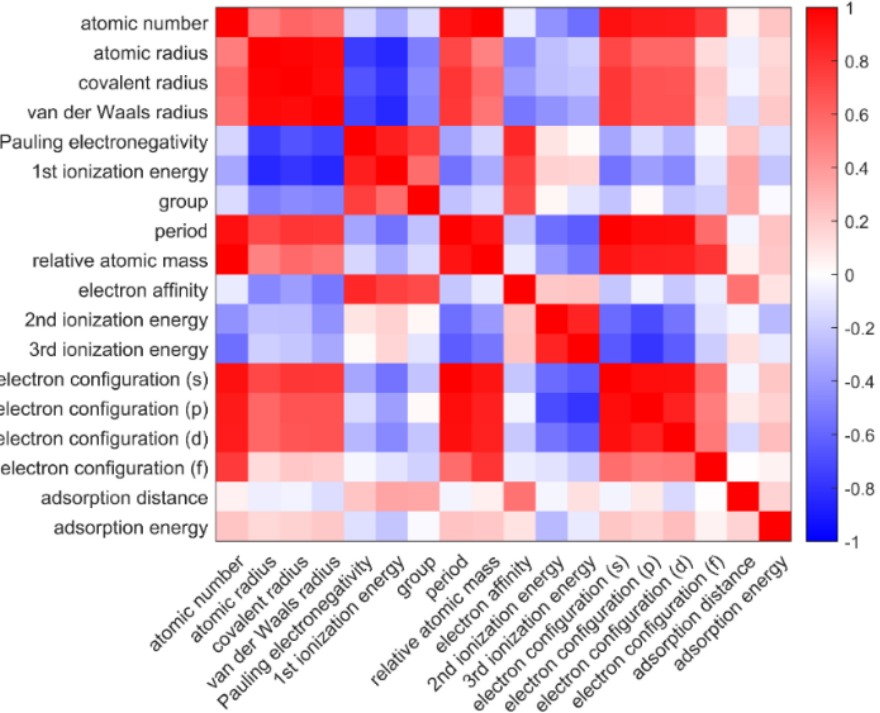
Figure 2. The heat map of Pearson correlation coefficient matrix among both the input features and the first principle calculated adsorption performances for adatom on graphene. The colors (blue and red) represent the positive and negative correlations.